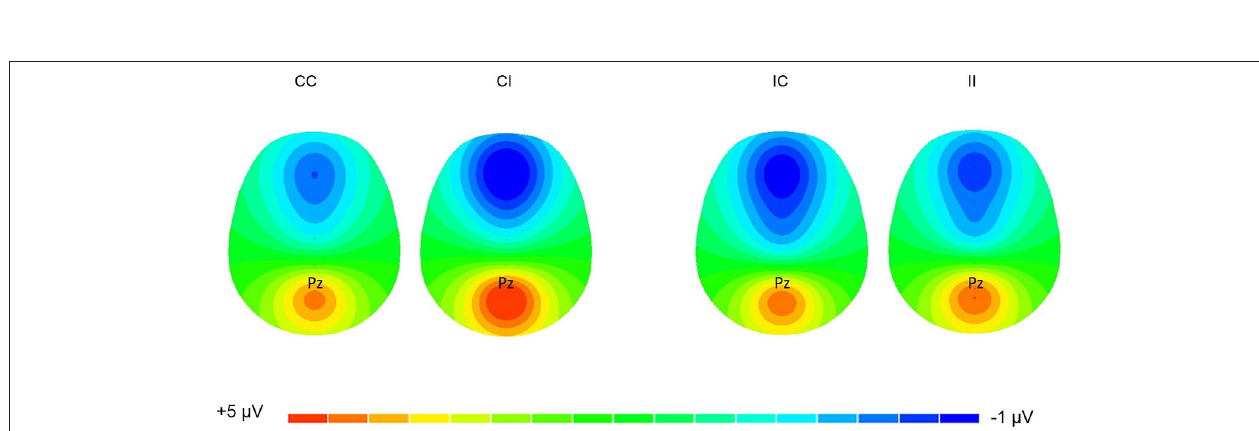
FIGURE 2 | Topographic distribution of P3 (400–550ms). The topographic distribution of P3 amplitude (spectrum: blue to red) is illustrated in CI, CC, IC, and II, respectively. CC, compatible congruent; CI, compatible incongruent; IC, incompatible congruent; II, incompatible incongruent.